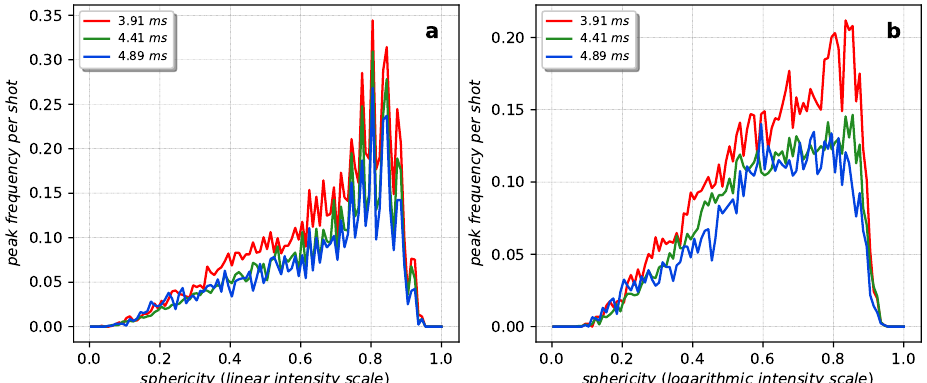
Figure A2. Frequency of a peak appearing with a certain sphericity for the hits above 50 ADU/pixel (full Q -range) in ( a ) linear and ( b ) logarithmic intensity